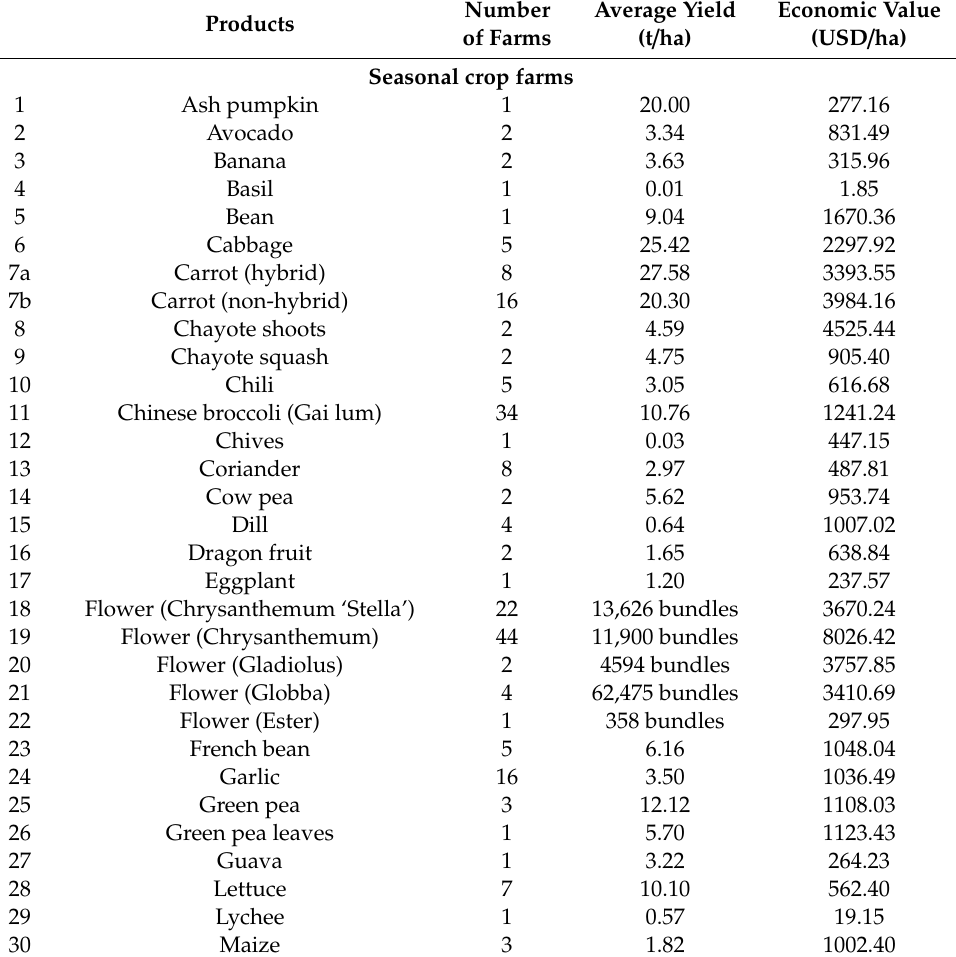
Table 1. Average yield and economic value of urban farm